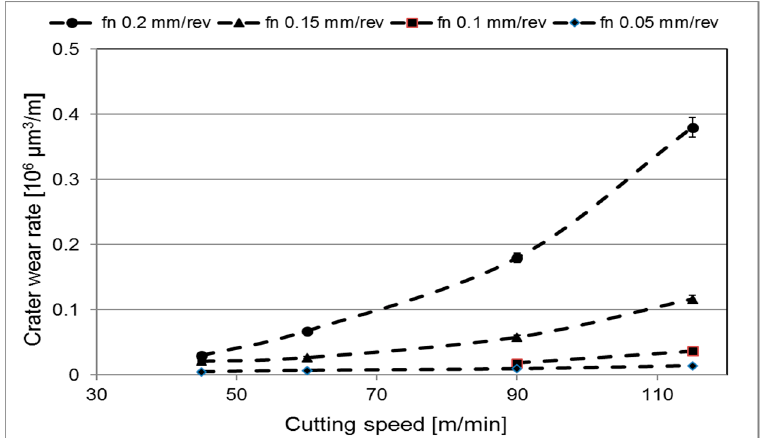
Figure 7 . Flank wear vs time at a feed rate of f n = 0.15 mm/rev and a cutting speed of v c = 45, 60, 90 and 115 m/min. Above 2 min the combination f n = 0.15 mm/rev and v c = 115 m/min results in extensive plastic deformation and macroscopic cracking.